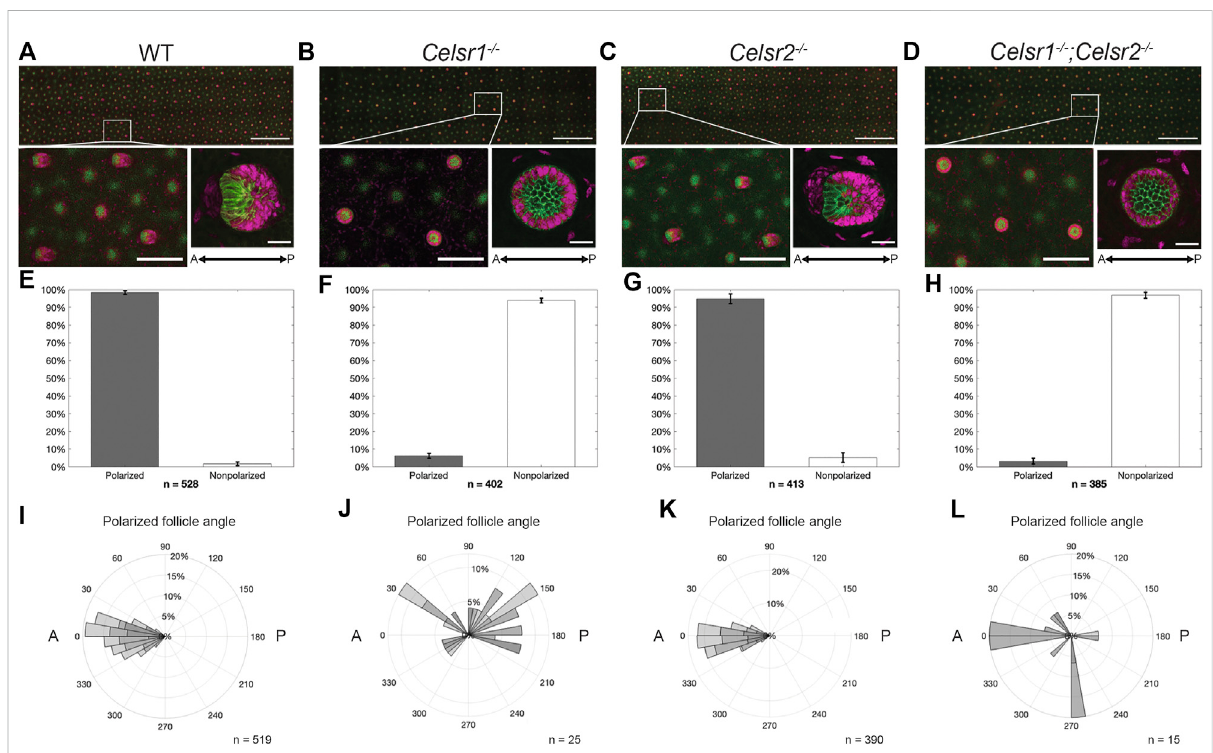
FIGURE 2 Celsr1, but not Celsr2, is necessary for correct asymmetric orientation of developing hair follicles. (A) Average intensity projection of WT embryonic back skin at E15.5, labelled for P-cadherin (green) and Sox9 (magenta). White box denotes zoomed in region shown below, left. Average intensity projection of a typical WT hair follicle imaged at higher mag (below, right). Scale bars: 1000, 200, and 25 µm, respectively. Anterior is to the left. (B – D) As for (A) , except Celsr1 − / − , Celsr2 − / − and Celsr1 − / − ;Celsr2 − / − respectively. (E) Bar chart showing cumulative percentage of polarized (grey bar) vs. non-polarized (white bar) hair follicles in n = 3 E15.5 back skins from 3 different embryos. n in fi gure represents total number of follicles analyzed. Error bars = SEM. (F – H) As for (E) , except Celsr1 − / − , Celsr2 − / − and Celsr1 − / − ;Celsr2 − / − respectively. (I) Rose plot of polarized follicles in (E) showing the angle of orientation, with anterior = 0 ° and posterior = 180 ° . Shaded areas in bars represent relative contribution of each replicate (n = 3 backskins from 3 different embryos), with n in fi gure representing total number of polarized hair follicles analyzed. (J – L) As for (I) , except Celsr1 − / − , Celsr2 − / − and Celsr1 − / − ;Celsr2 − / −